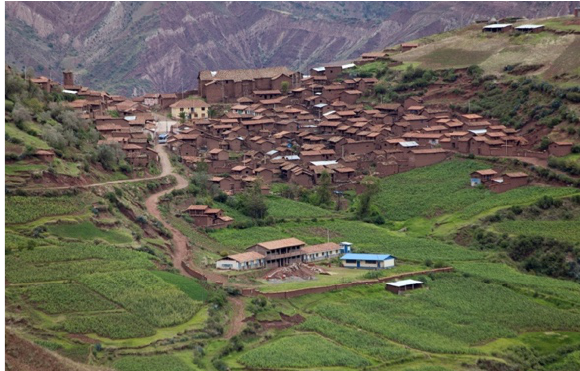
Figure 1 . View of the village of Kuñotambo, showing the church of Santiago Apóstol and the bell tower before the